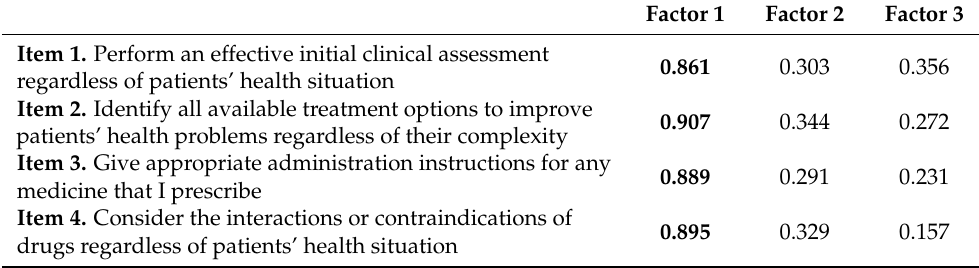
Table 2. Exploratory factor analysis (EFA) results and structure of the Galician version of the Nurse Prescribing Self-Efficacy Scale (G-NP-SES) ( n =